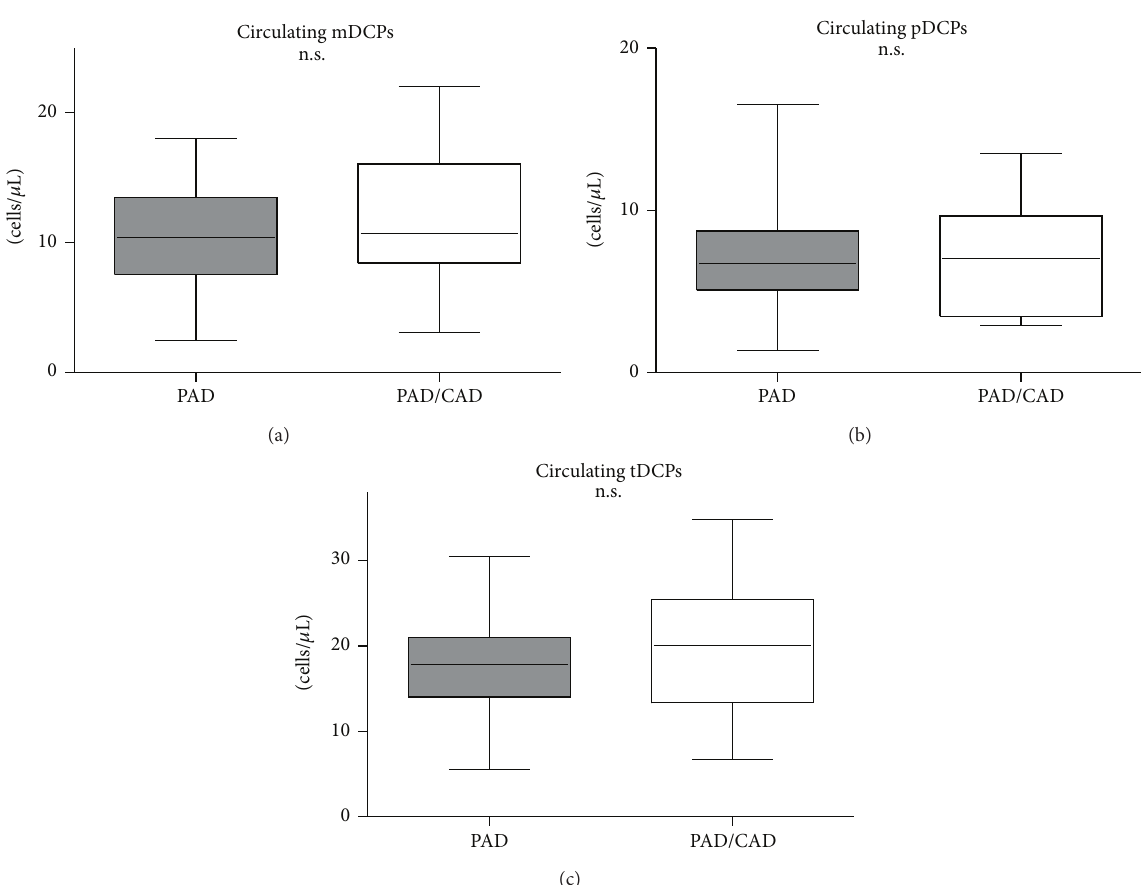
Figure 4: Frequency of circulating mDCPs, pDCPs, and tDCPs in patients with PAD compared with patients with PAD and CAD. Absolute numbers of circulating mDCPs (a), pDCPs (b), and tDCPs (c) (cells/ 𝜇 L) are shown. The box plots indicate the median (line inside the box), 25th and 75th percentile (lower and upper boundary of the box), and 10th and 90th percentile (whiskers outside box).